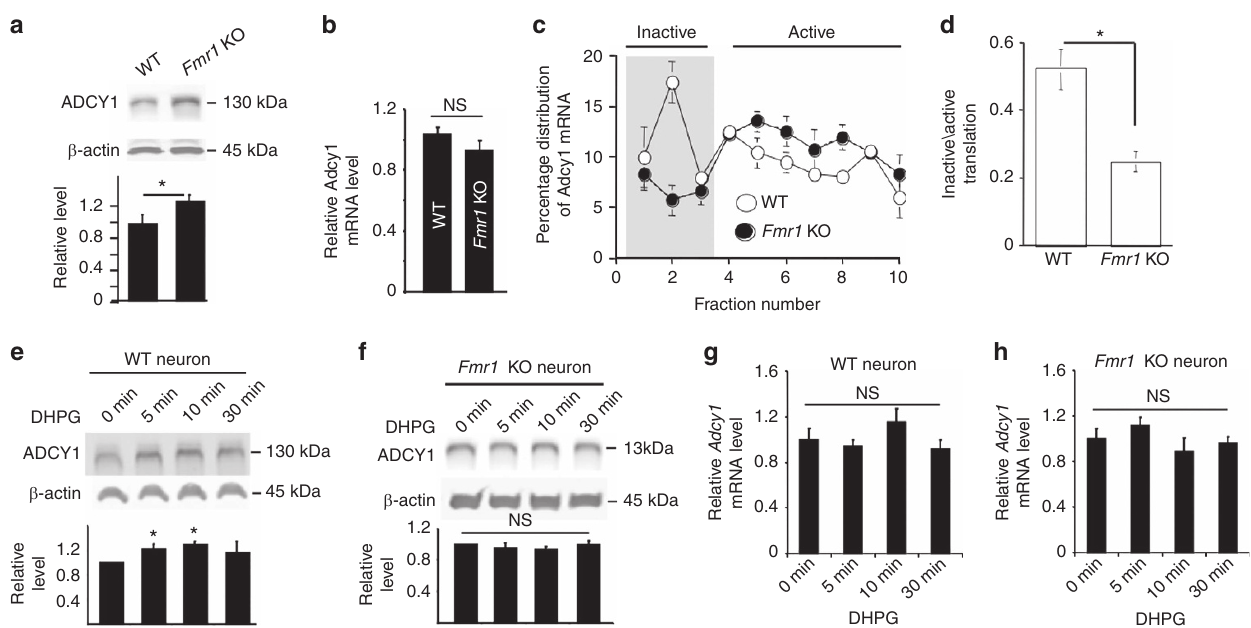
Figure 1 | FMRP negatively regulates Adcy1 mRNA translation. ( a ) The level of ADCY1 protein from the hippocampus of WT and Fmr1 KO mice. The representative Western blot result is shown in the top panel, and quantification (normalized to b -actin) is shown in the bottom panel. * P ¼ 0.021, n ¼ 6 per group, Student’s t -test. ( b ) Adcy1 mRNA level in WT and Fmr1 KO hippocampus was determined by qRT-PCR ( n ¼ 6 per group). ( c ) Distribution of Adcy1 mRNA in different ribosome fractions obtained by linear sucrose gradient centrifugation from hippocampal lysates of WT ( n ¼ 3) and Fmr1 KO mice ( n ¼ 3). ( d ) The ratio of Adcy1 mRNA in ribosome fractions 1–3 to fractions 4–10. * P ¼ 0.026, n ¼ 3 per group, Student’s t -test. ( e – h ) Cultured WT ( e , g ) and Fmr1 KO ( f , h ) hippocampal neurons ( n ¼ 6 per group) were stimulated with the mGluR1/5 agonist DHPG (100 m M) for various durations (as indicated). The level of ADCY1 protein ( e , f ) and mRNA ( g , h ) following DHPG treatment were determined by western blot (normalized to b -actin) and qRT-PCR (normalized to Gapdh mRNA level), respectively. *: significant difference between control and the indicated group; P ¼ 0.032 (for the 5min post-treatment group) and P ¼ 0.046 (for the 10min post-treatment group), determined by one-way ANOVA ( n ¼ 6 for each group, F 3,20 ¼ 3.927, P ¼ 0.021) followed by